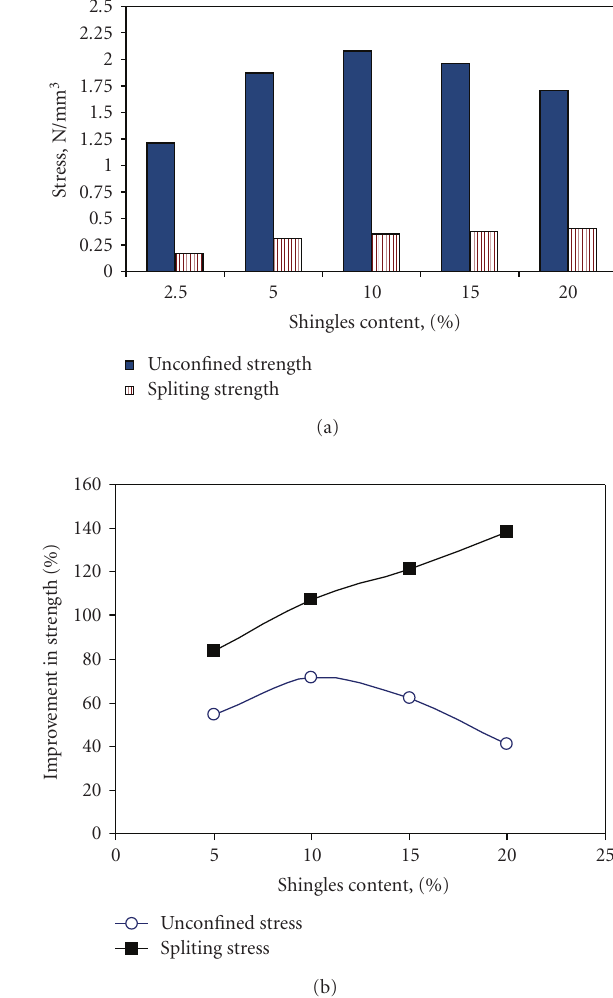
Figure 3: E ff ect of shingle content on compressive and tensile strengths: (a) di ff erent shingle contents (with 10% CKD2) and (b) percentage